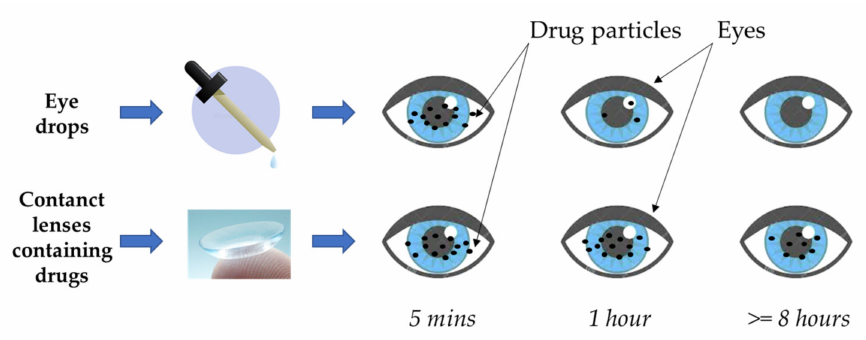
Figure 1. Schematic representation of drug release time for contact lenses and conventional topical formulation